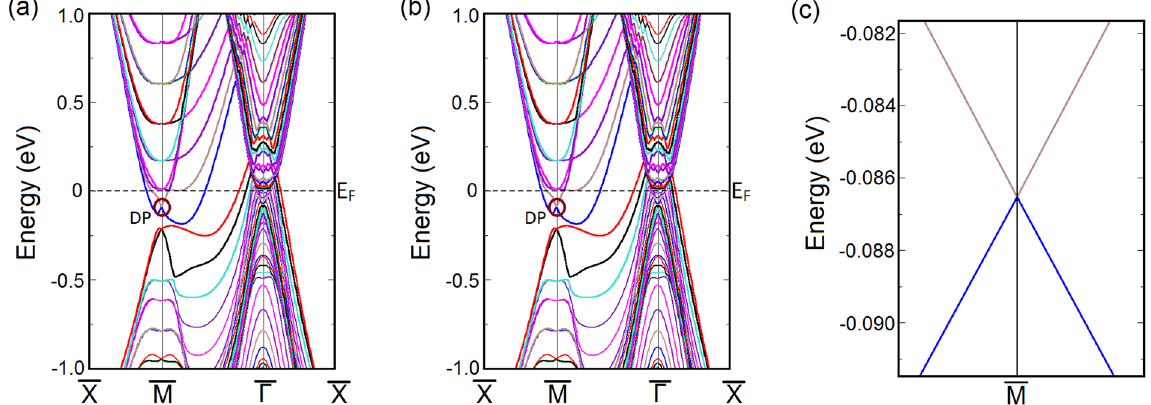
Figure 6. ( a ) Unperturbed (001) surface band structure of LaBi. The Dirac point (DP) found at the M -point is encircled. ( b ) (001) surface band structure of LaBi when the c / a ratio of the slab is changed by ∼ 2%. ( c ) Corresponding Dirac cone at the M -point remains stable even after the application of a TR-preserving perturbation. This robustness of the surface states bears testimony to the topological nature of LaBi in contrast to